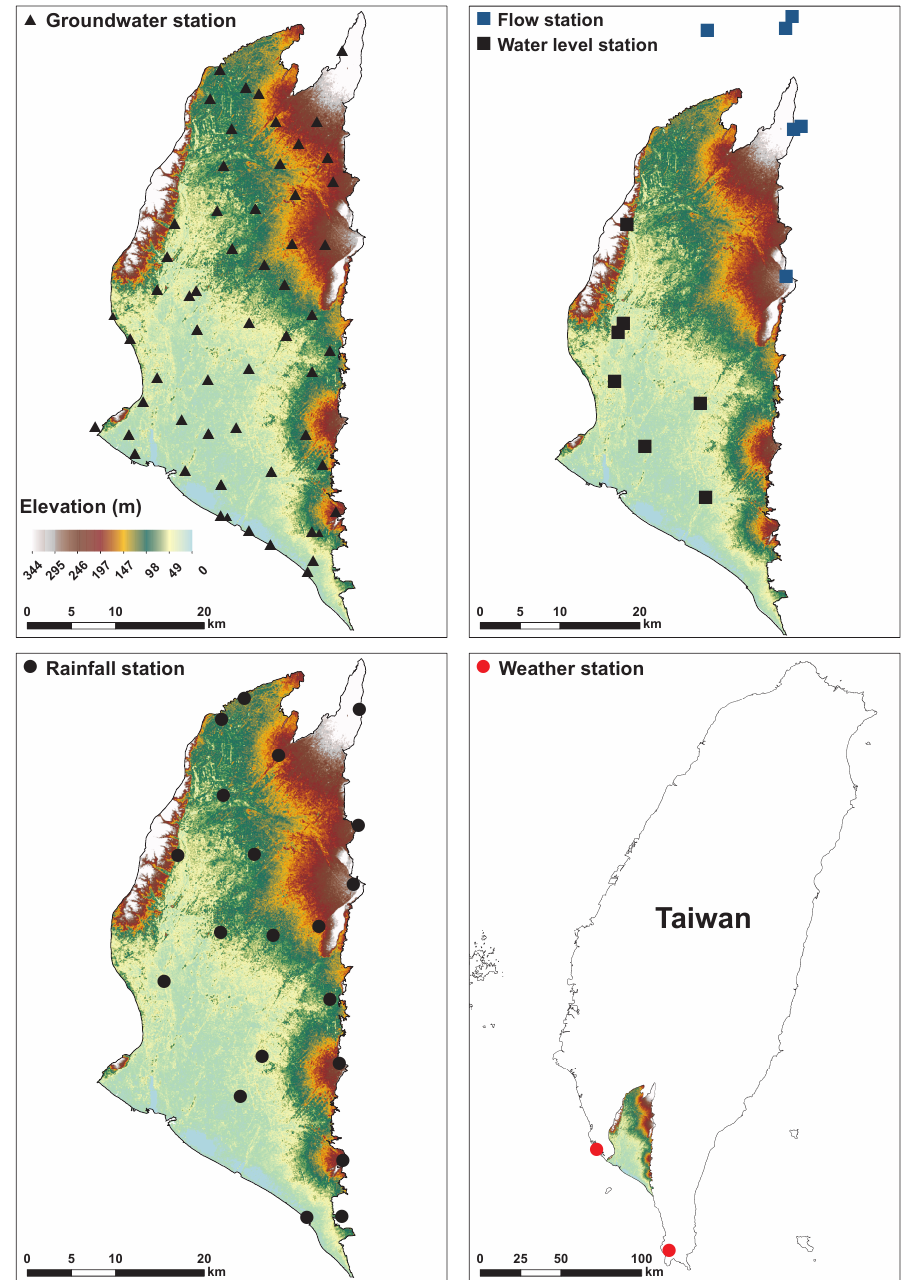
Figure 2. Spatial locations of various stations, including groundwater level, streamflow, rainfall, and weather